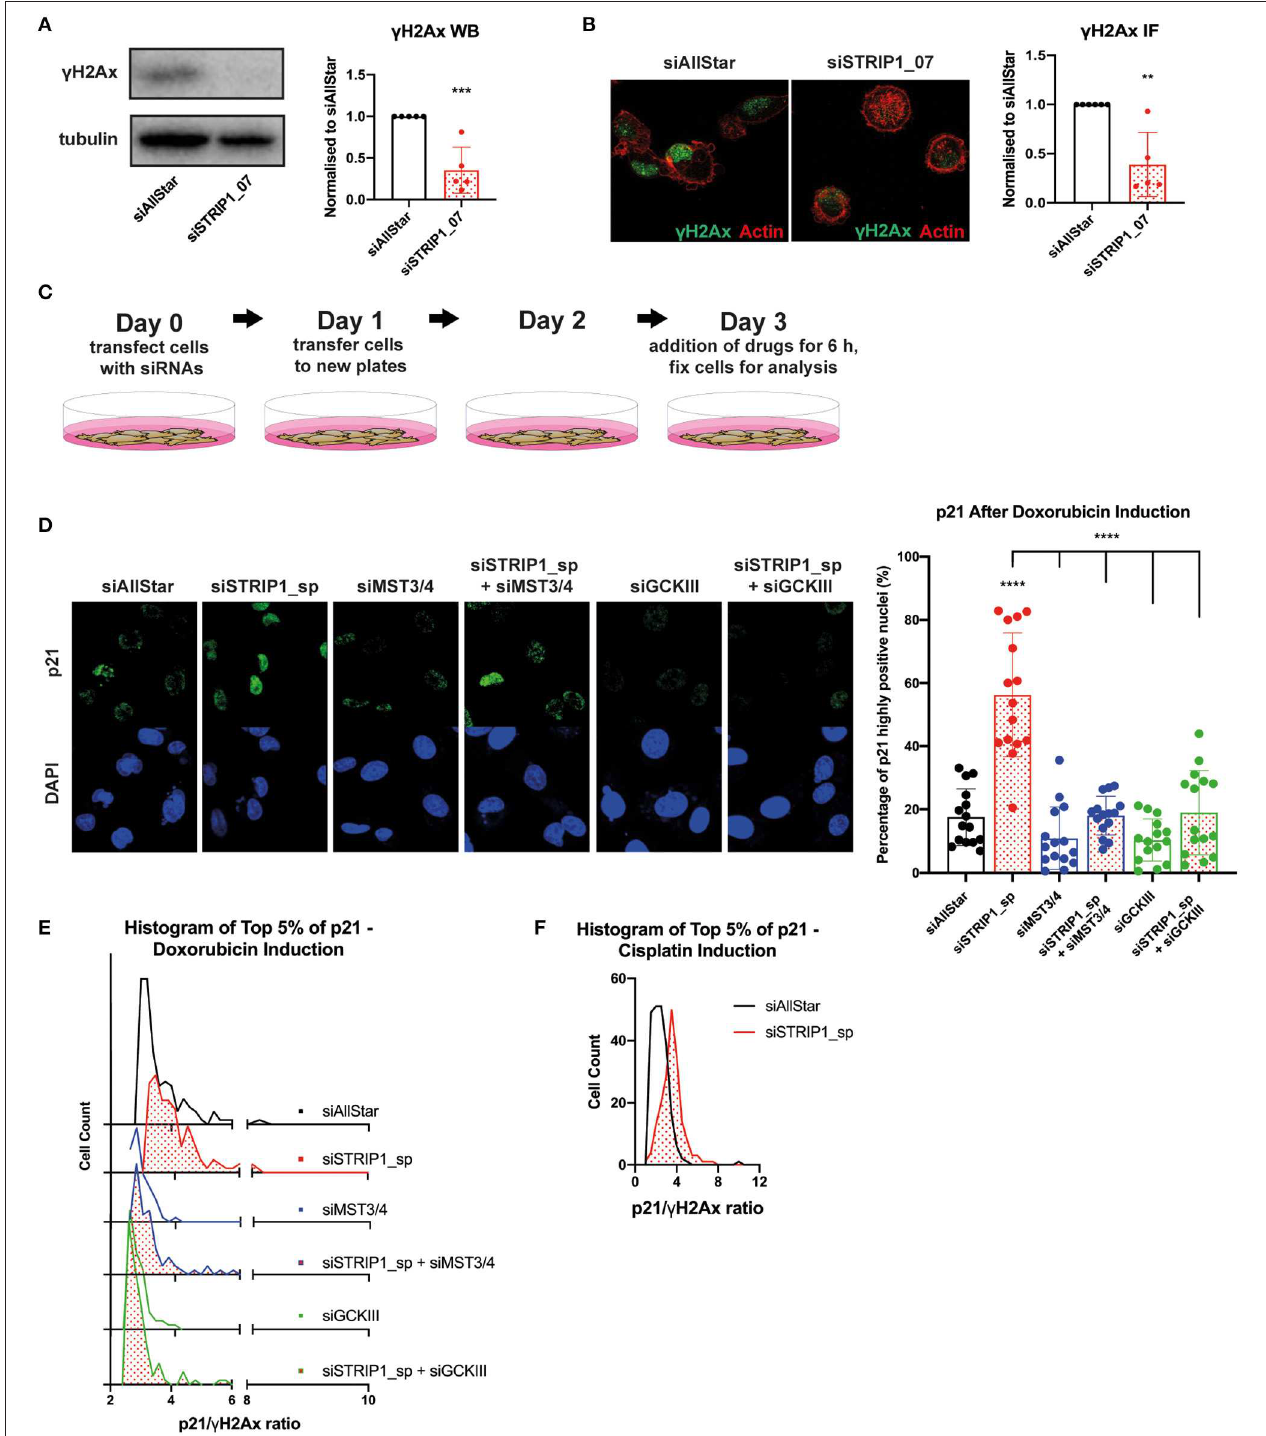
FIGURE 4 | STRIP1 regulates DNA damage response. (A) Loss of STRIP1 suppresses the DNA damage response as measured by γ H2AX immunoblotting with quantification. (B) Loss of STRIP1 suppresses the DNA damage response also measured by immunofluorescence with quantification. (C) Experimental set-up of the drug treatment experiment. (D–F) siRNA-depleted MDA-MB-231 cells were treated with high dose chemotherapeutics 72h post-transfection. (D) Depletion of MST3&4 represses p21 induction after loss of STRIP1 even after high dose chemotherapeutics. The percentage of siRNA-depleted MDA-MB-231 cells expressing high levels of nuclear p21 after high dose doxorubicin treatment was quantified. (E) Loss of STRIP1 increases the p21/ γ H2AX ratio in a MST3&4 dependent manner